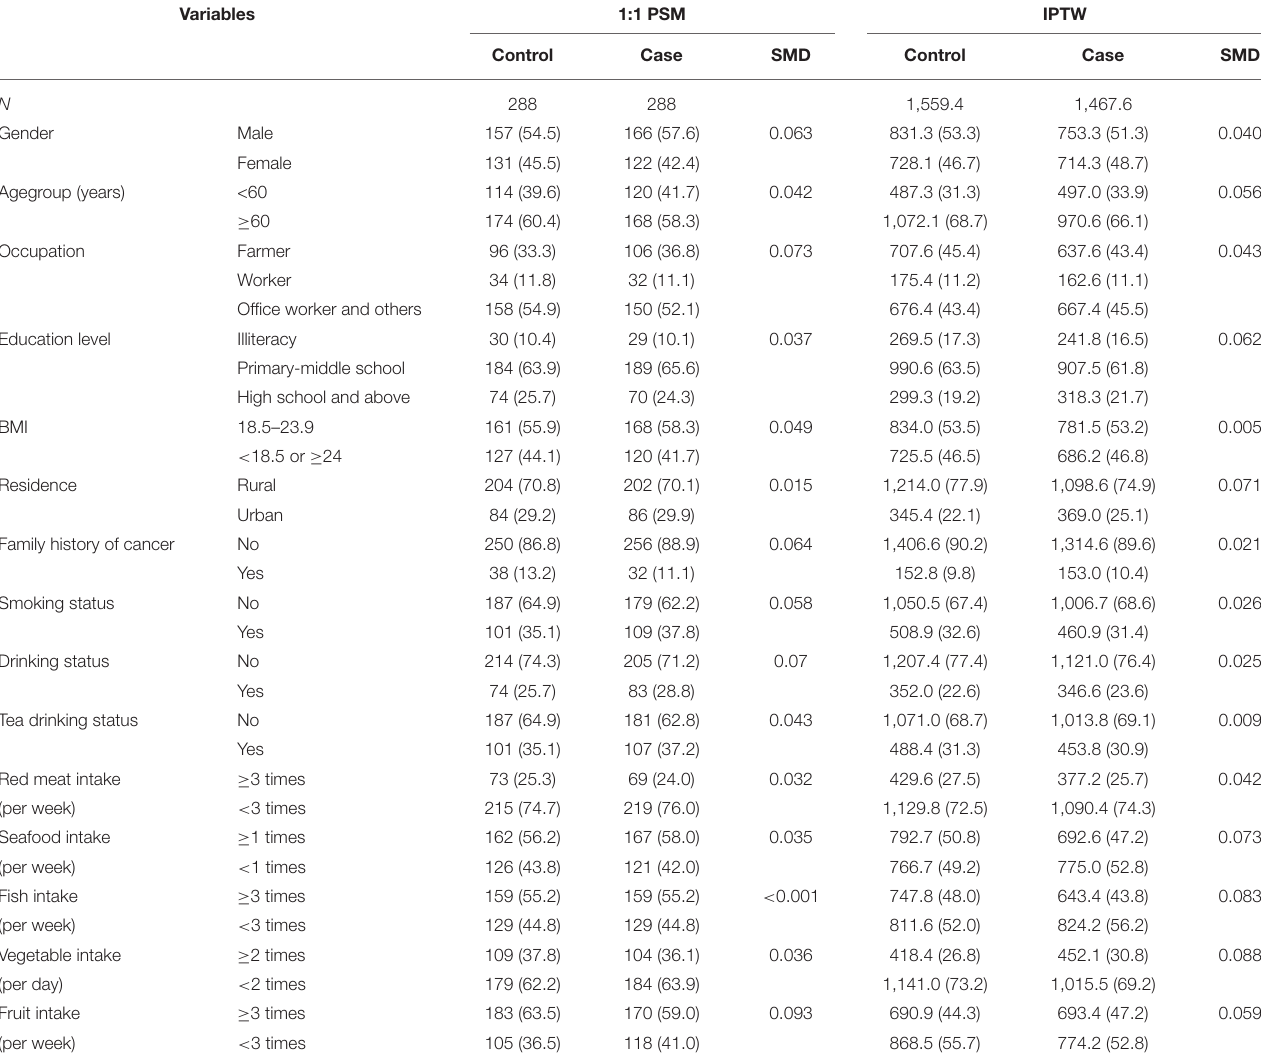
TABLE 1 | Baseline characteristics of case and control groups in PSM and IPTW population.